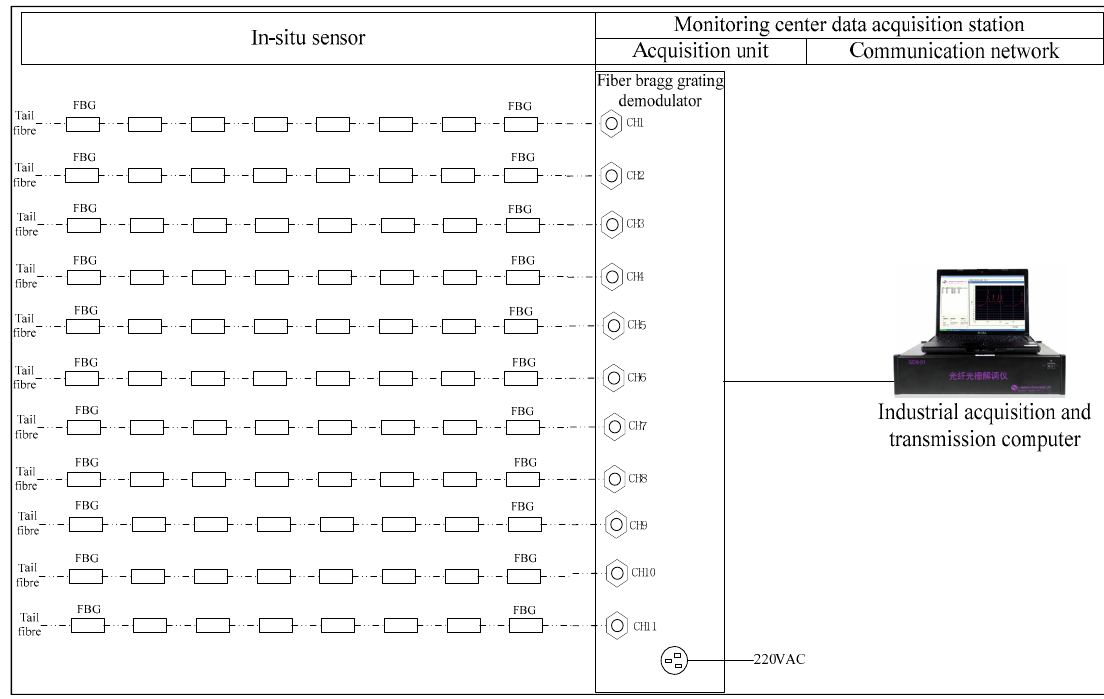
Figure 6. Framework of data acquisition and transmission network topology for stress-strain and cable force monitoring.